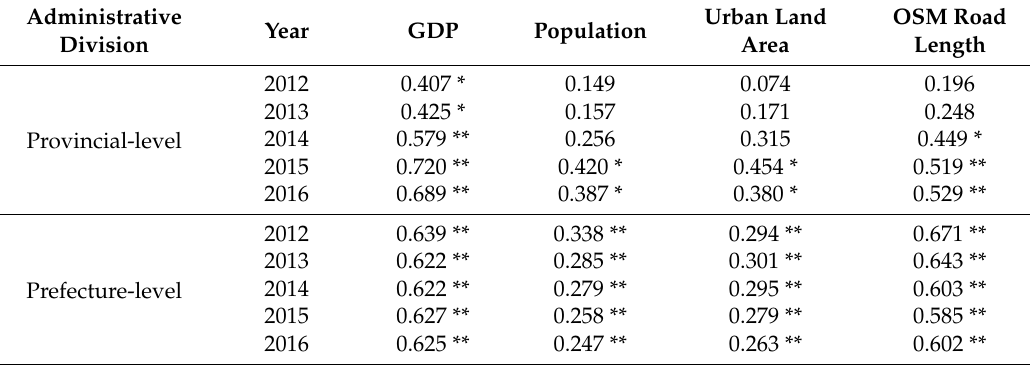
Table 1. Correlations among OSM building counts and four potential factors for 2012 to